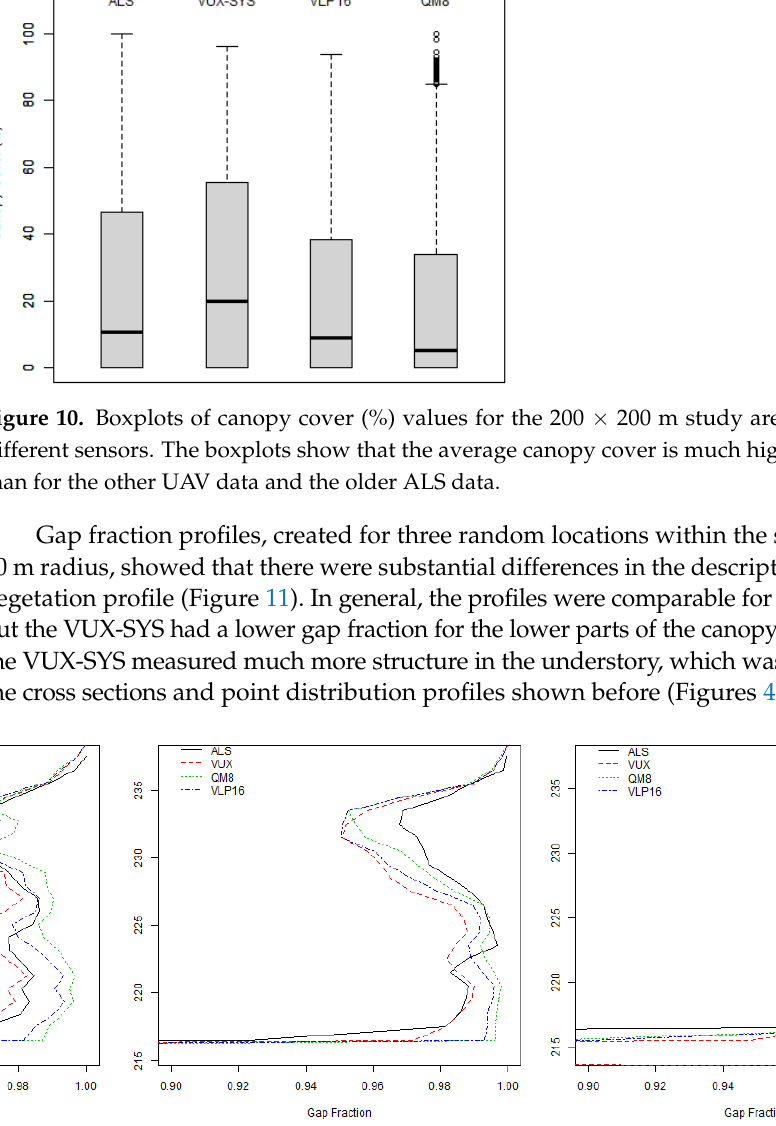
Figure 11. Gap fraction profiles of three randomly selected 20 m radius areas plots. Height is given in m.a.s.l.